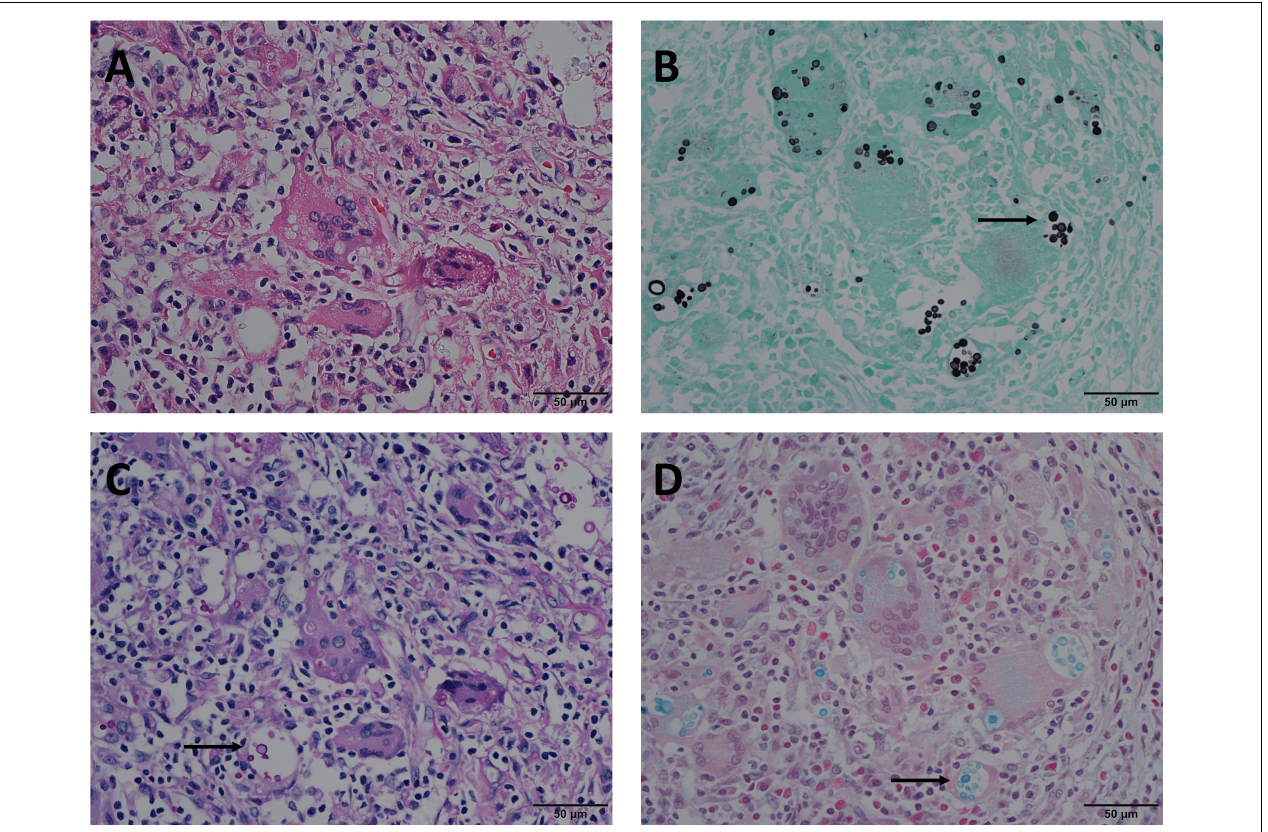
FIGURE 1 | Mode A: GMS(+), PAS(+), AB(+) in the same view of lung tissues with pulmonary cryptococcosis (male, aged 42 years, multiple nodules, maximum diameter of 1 cm). (A) H&E staining reveals morphological characteristics of granulomatous inflammation, and circular structures resembling Cryptococcus spores. (B) GMS(+) reveals Cryptococcus spores (arrow) that are clear, brown-black, round, or oval structures, with different sizes and clear morphological characteristics such as capsule and narrow-based budding against the bright green and clean background. (C) PAS(+) reveals Cryptococcus spores (arrow) stained magenta of varied intensity, including some very lightly stained structures. (D) AB(+) reveals Cryptococcus spores (arrow) stained blue of varied intensity. GMS, Grocott methenamine silver; PAS, periodic acid-Schiff; AB, Alcian blue; H&E, hematoxylin and eosin. (Original magnifications: A–D , ×